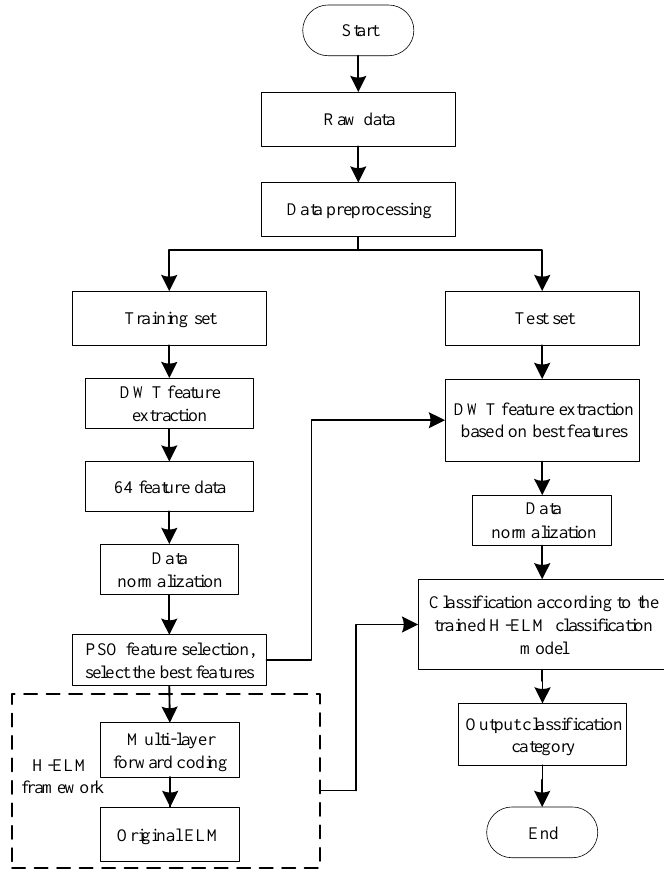
Figure 2. Classification flowchart based on the H-ELM algorithm.